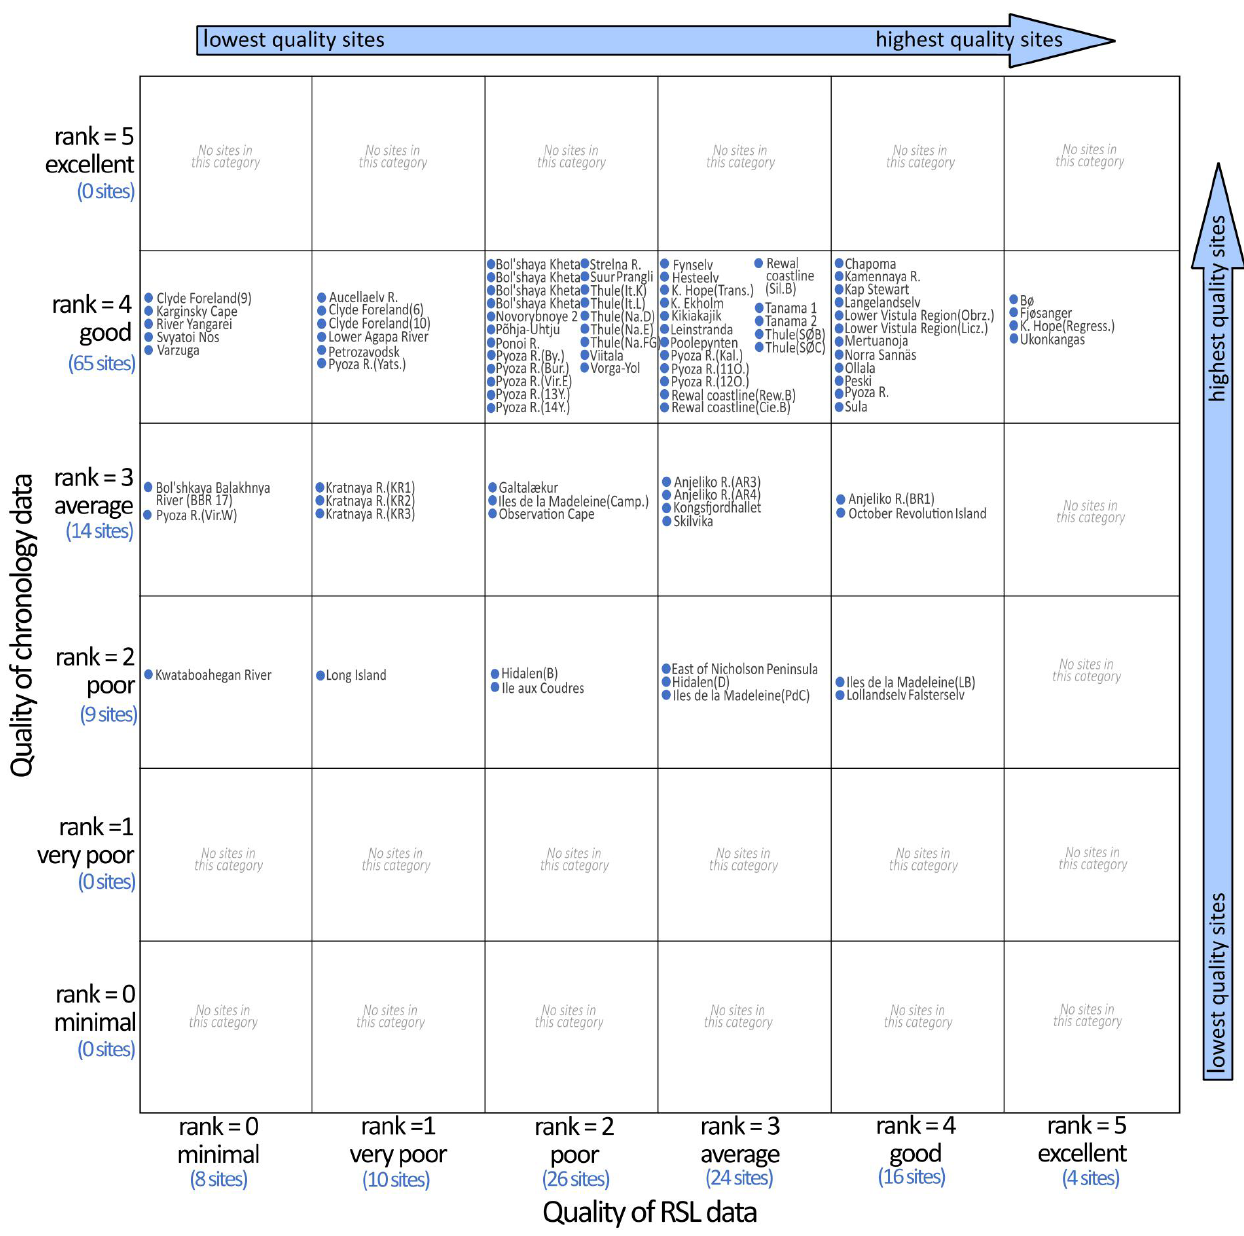
Figure 15. Schematic diagram showing each site with quality scores for the RSL data (horizontal axis) and chronology data (vertical